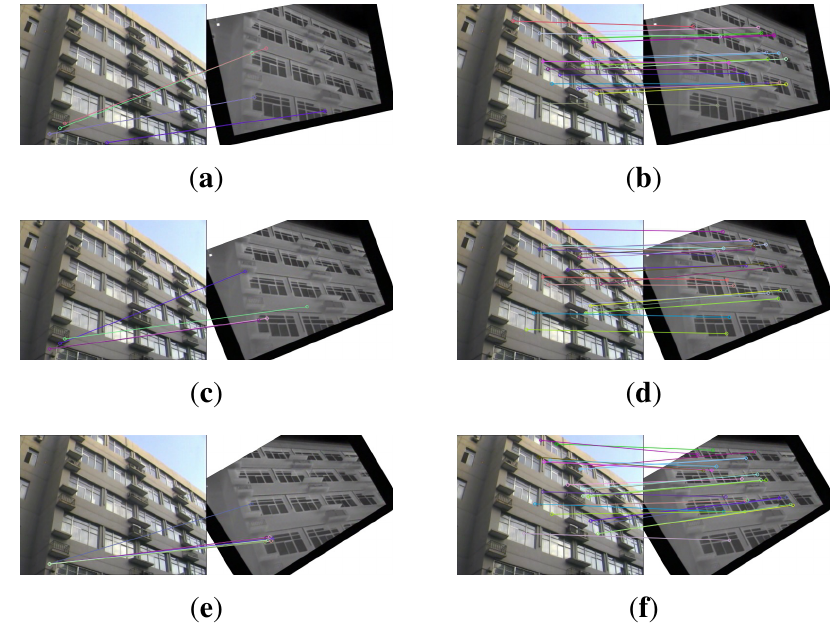
Figure 3. The matching performance under rotation. The test image is rotated by 10 ◦ , 20 ◦ , and 30 ◦ from top to bottom line. The left column is the result of EOH without main orientation.